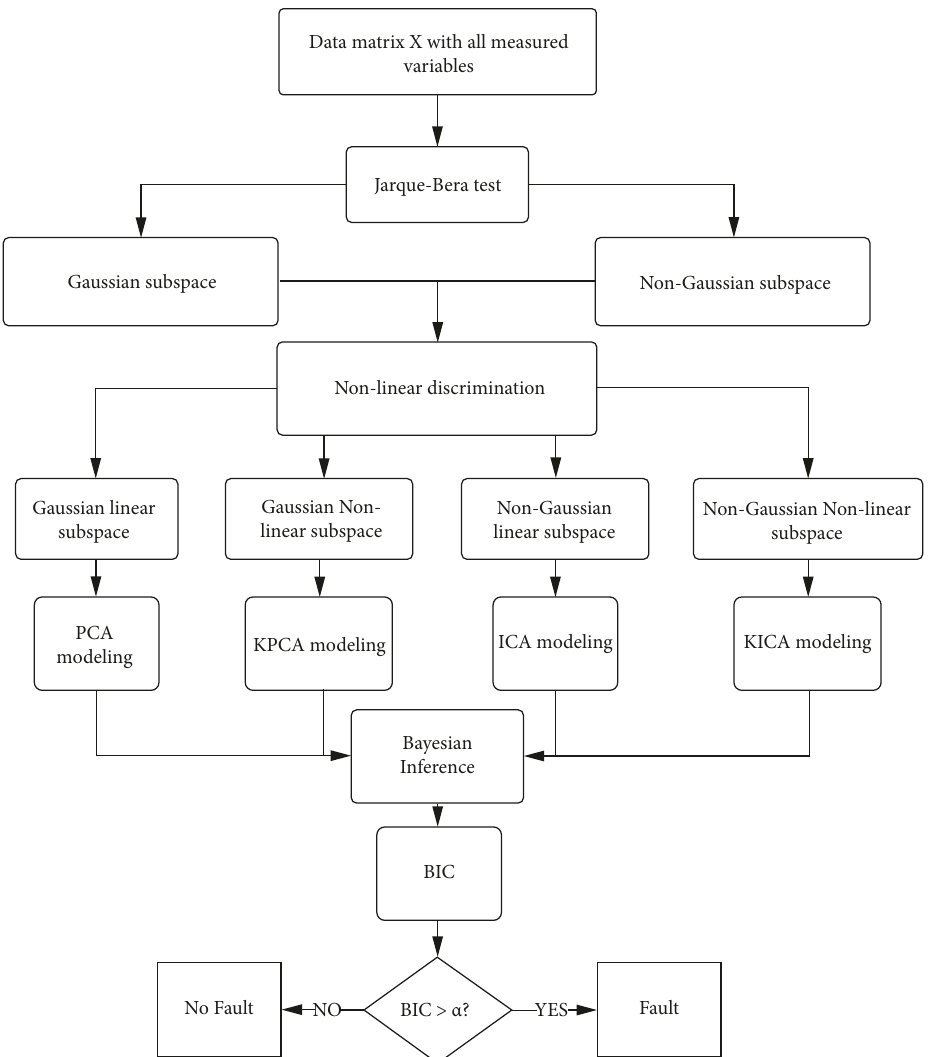
Figure 1: Flowchart for the PCA-KPCA-ICA-KICA-BI monitoring